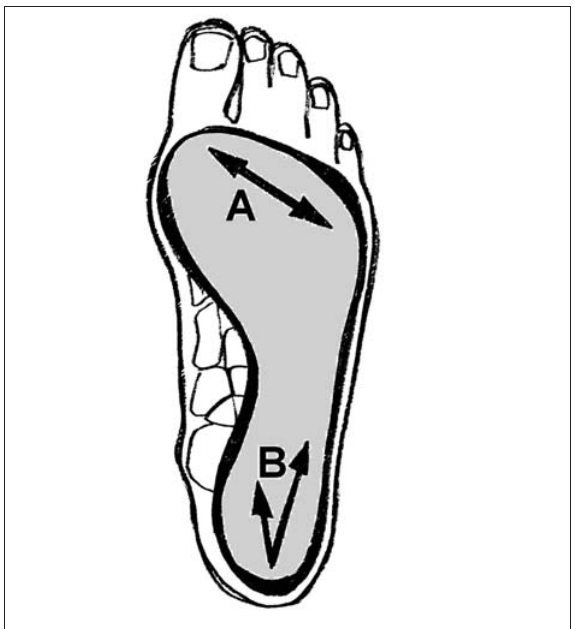
Figure 1. Trajectory of the median across the support base while standing on one leg (according to